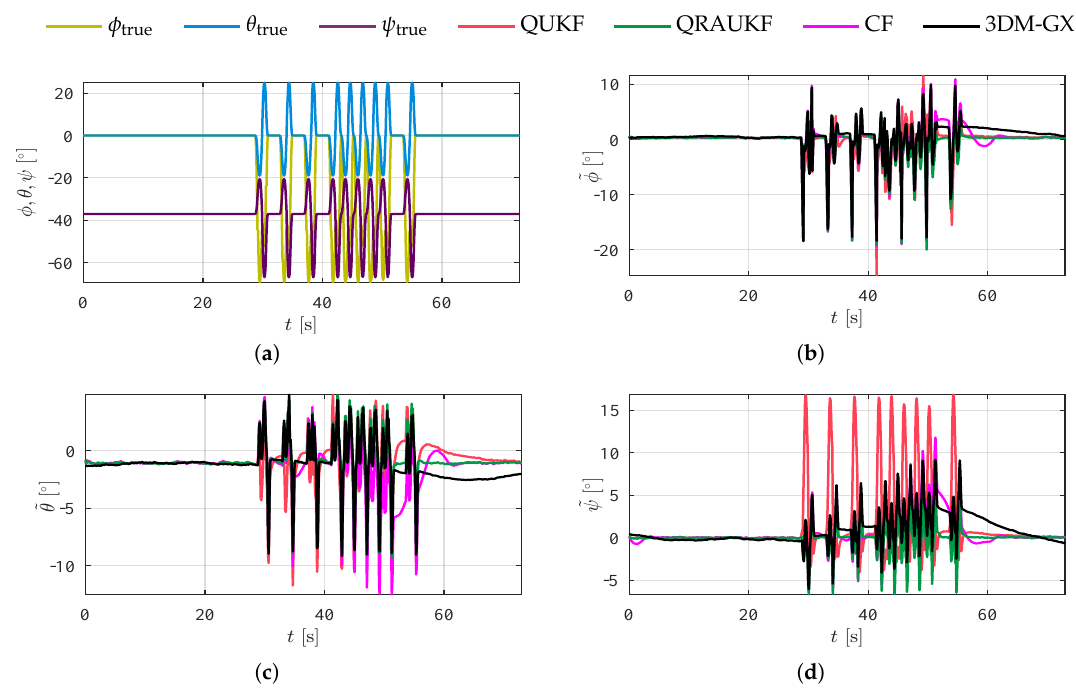
Figure 10. Results for simultaneous axes rotation about the origin, scenario (v). ( a ) shows actual orientation for simultaneous axes movements; ( b – d ) show the estimation error for φ , θ and ψ angles,